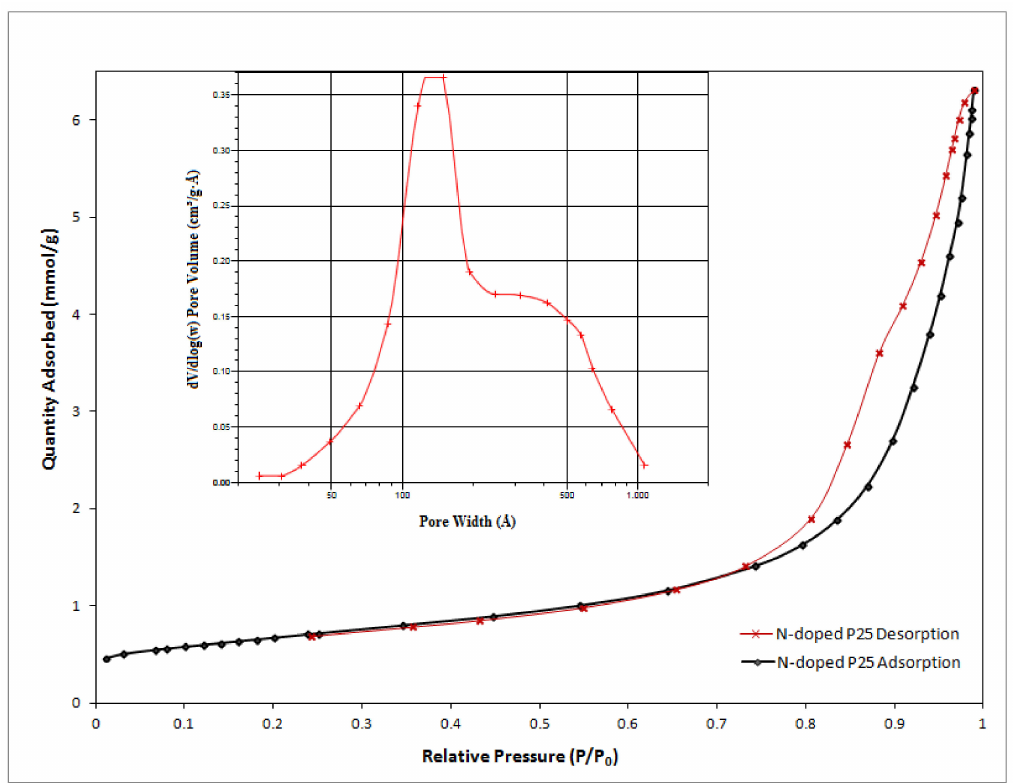
Figure 2. Nitrogen adsorption-desorption isotherms of as-prepared N-doped P25. The inset shows the Barrett-Joyner-Halenda (BJH) pore size distribution curve.